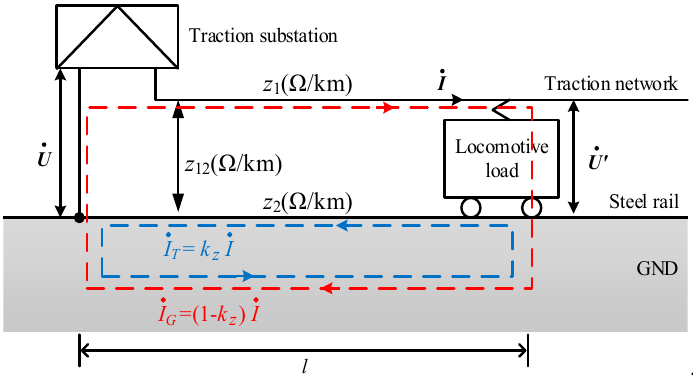
Figure 6. The simplified impedance model of the traction network.